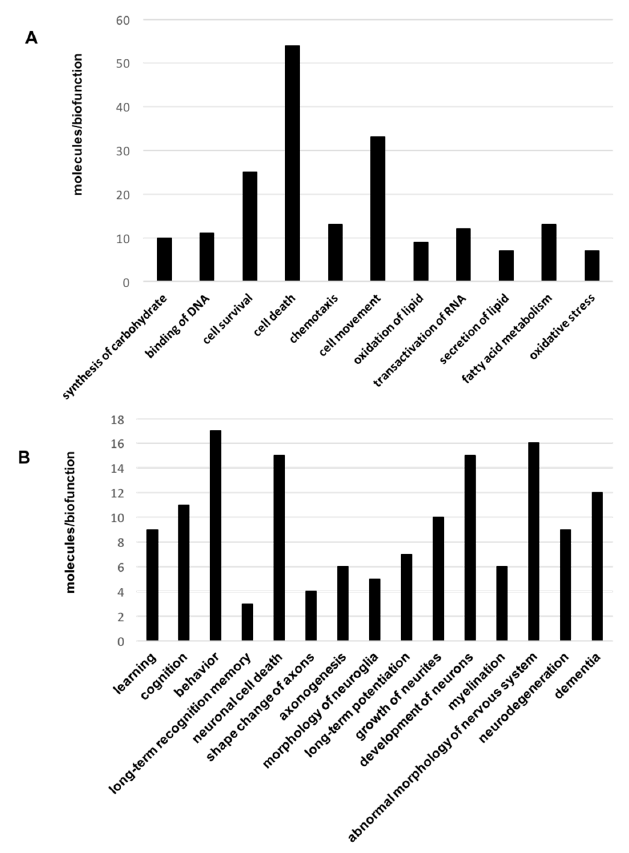
Figure 3. Significantly represented biofunctions in the OB of aged Tg2576 mice. Canonical ( A ) and neuronal-specific ( B ) over-represented biofunctions in omic datasets derived from 18-month-old Tg2576 mice. In ( A ), 45 out of 54 molecules present in cell death category are related to apoptosis (See Table S4).